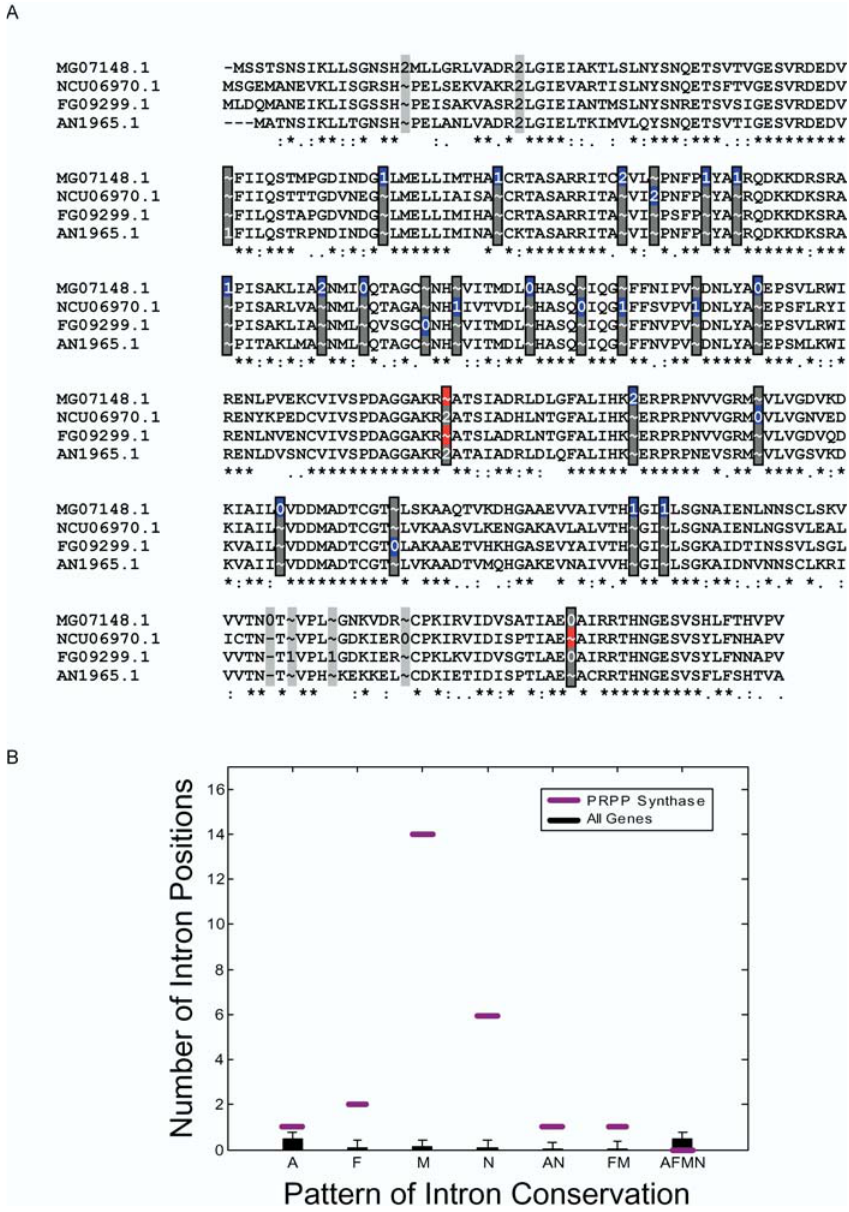
Figure 5. Intron Conservation in the PRPP Synthetase Gene (A) Alignment of PRPP synthetase puta- tive orthologs MG07148, NCU06970, FG09299, and AN1965. A black-edged rectangle indicates an intron position passing our quality filters, whereas an unedged gray rectangle indicates an intron position that was removed by our filter. Blue boxes mark raw intron gains, red boxes indicate raw intron losses, and gray boxes within black-edged rectangles highlight all other introns. We manually corrected an annotation error in the first intron of the last row of the alignment. (B) Phylogenetic conservation pattern of introns in the PRPP sythetase gene. Each passing intron position was categorized as being present in A. nidulans (A), F. graminearum (F), M. grisea (M), N. crassa (N), A. nidulans and N. crassa (AN), F. graminearum and M. grisea (FM), or all four organisms (AFMN). There are no passing cases of conservation in three or four species. The number of introns in each category is shown with a purple line. The black error bar plot shows the mean and standard deviation for each category for all 2,008 ortholog sets after fitting to a Poisson distribution (see Materials and Methods). The number of introns in M. grisea and N. crassa is significantly higher, at the p , 1 3 10 (cid:1) 9 level. DOI: